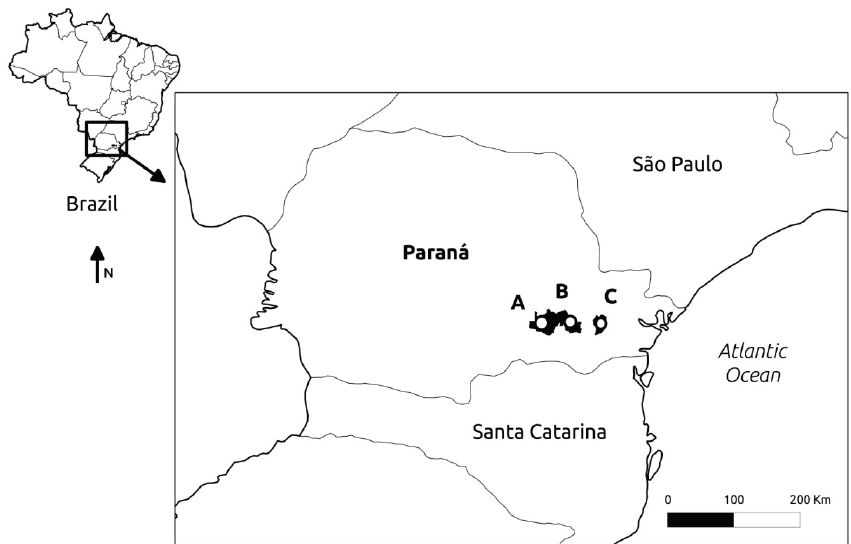
Figure 5. Locations of the different populations of Salvia lachnostachys Benth. in Paraná State, Brazil; (A) Palmeira; (B) São Luiz do Purunã; (C)